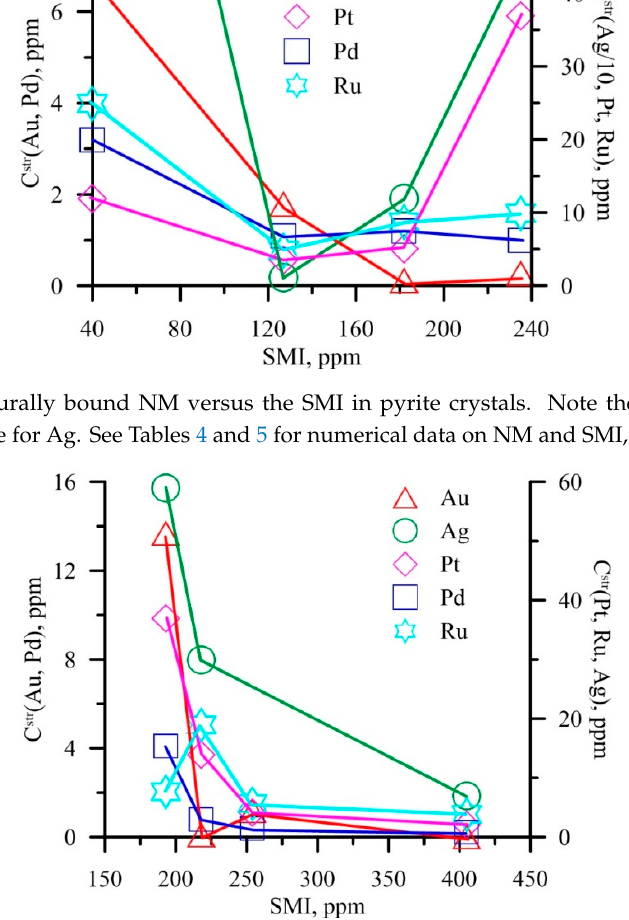
Figure 16. Structurally bound NM versus the SIM in arsenopyrite crystals. See Tables 4 and 6 for numerical data on NM and SMI, accordingly.